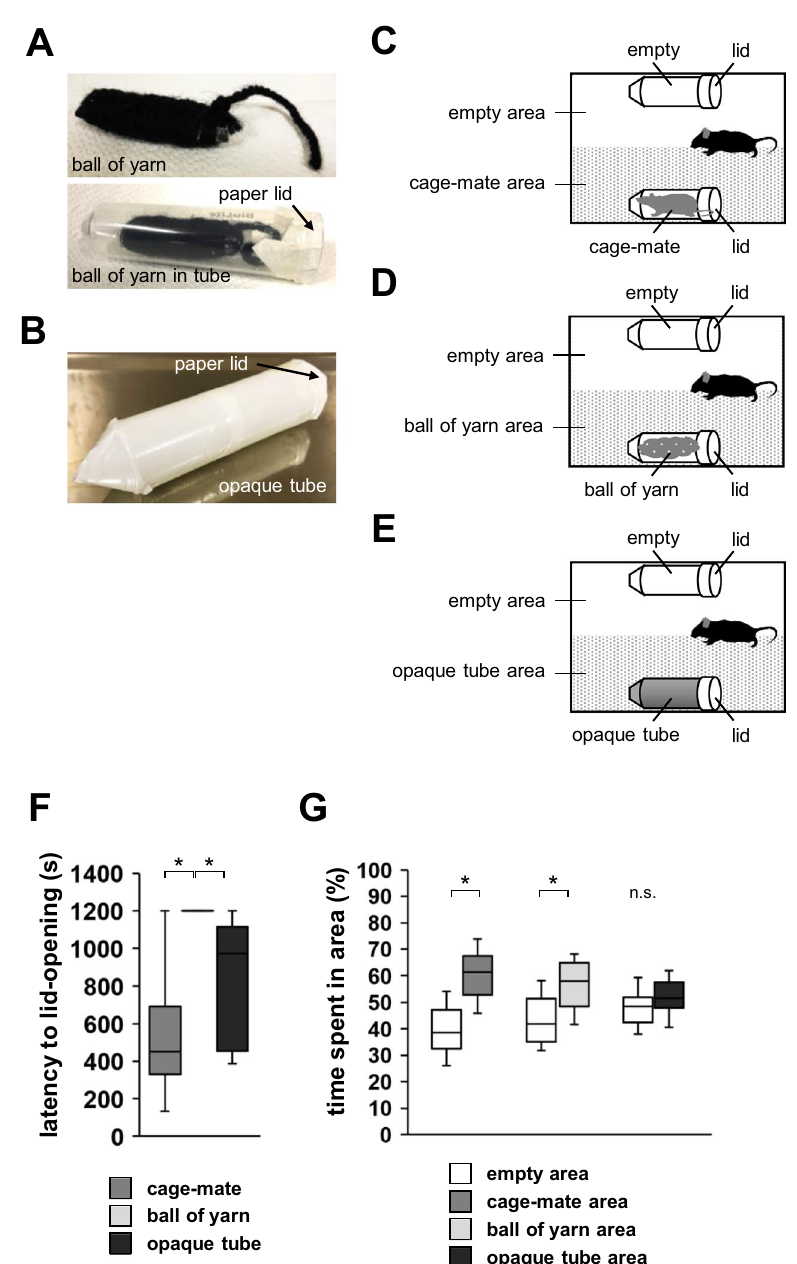
Figure 2. Rescue-like behaviour test depending on the tube condition. ( A ) Upper row: a sample image of the ball of yarn. Lower row: a sample image showing the back of the tube containing the ball of yarn with a paper lid. ( B ) A sample image of an opaque 50-mL tube with a paper lid. ( C ) Schematic diagram of the test. Rescue-like behaviour test for cage-mates: time spent in the cage-mate area or the empty area. ( D ) Rescue-like behaviour test for a ball of yarn: time spent in the ball of yarn area or the empty area. ( E ) Rescue-like behaviour test for the opaque tube: time spent in the opaque tube area or the empty area. ( F ) Comparison of the latency to lid-opening in the three tests. ( G ) Comparison of the time spent in each area of the three tests. All data are presented as box plots. Statistical significance is represented as * p < 0.05. n.s., not significant. The p values were calculated by one-way repeated measures ANOVA ( F ) and paired t -test ( G ). n = 10 animals per